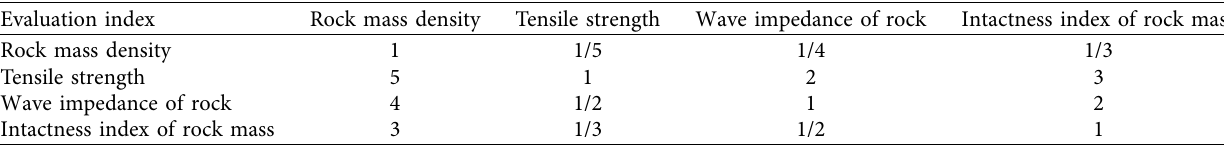
Table 3: Comparison of the importance of each index of rock fracture ability